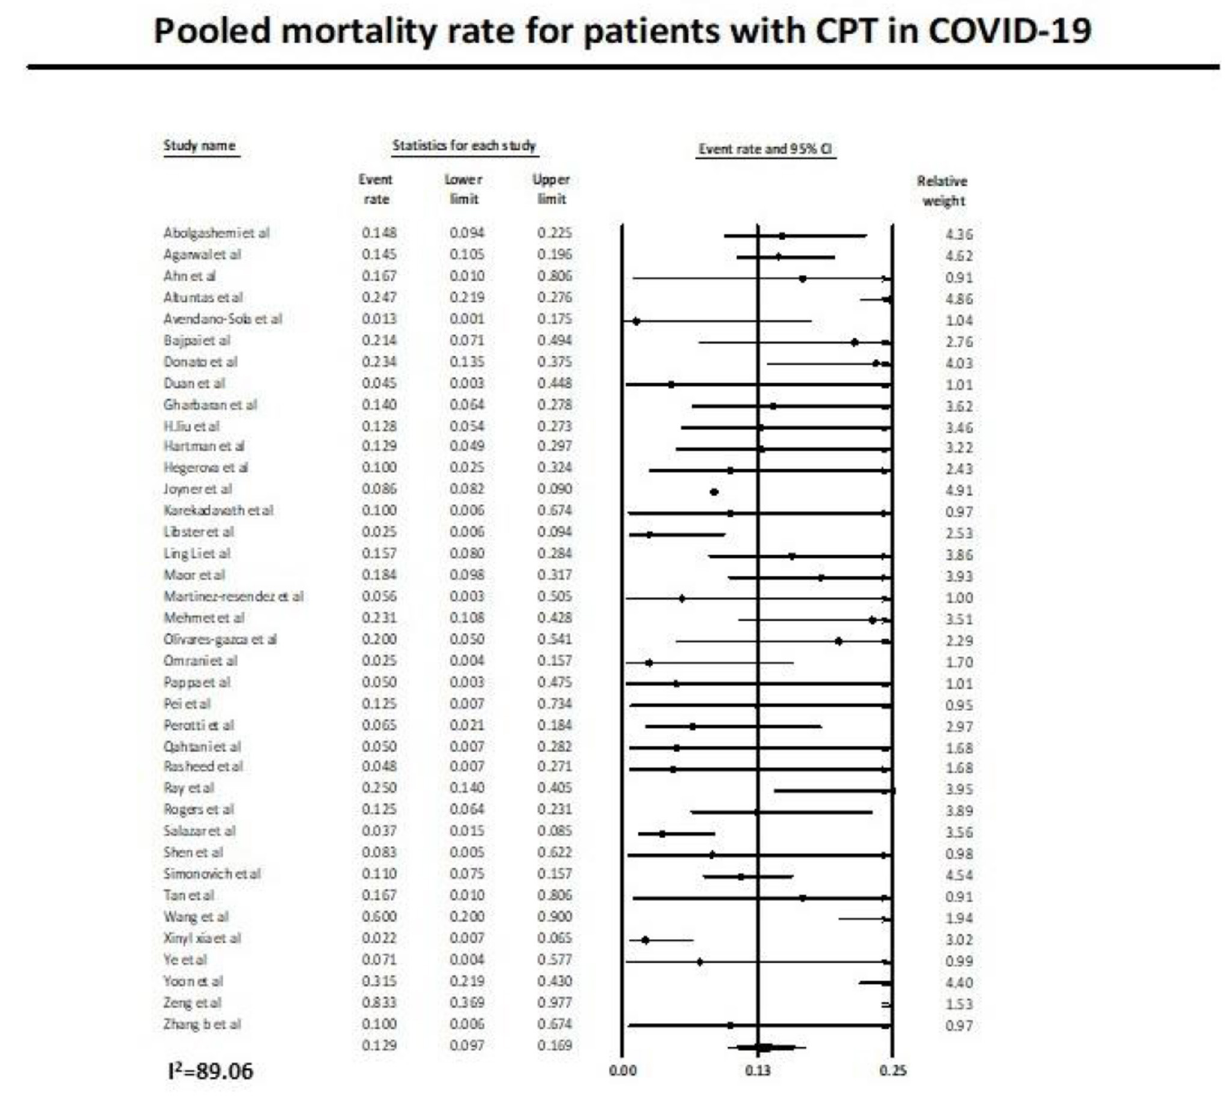
FIGURE 3 | Pooled mortality rate with use of CPT in